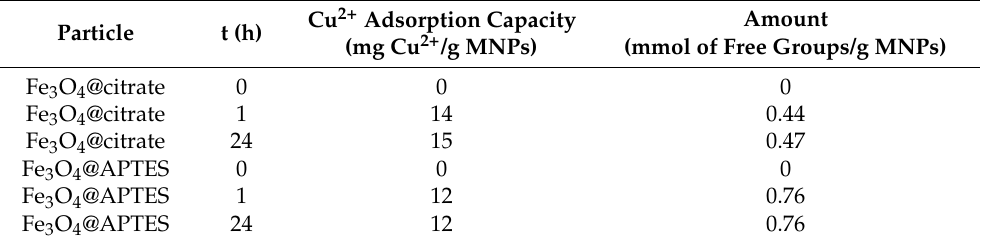
Table 1. Determination of the degree of substitution on the MNPs using the bicinchoninate method.